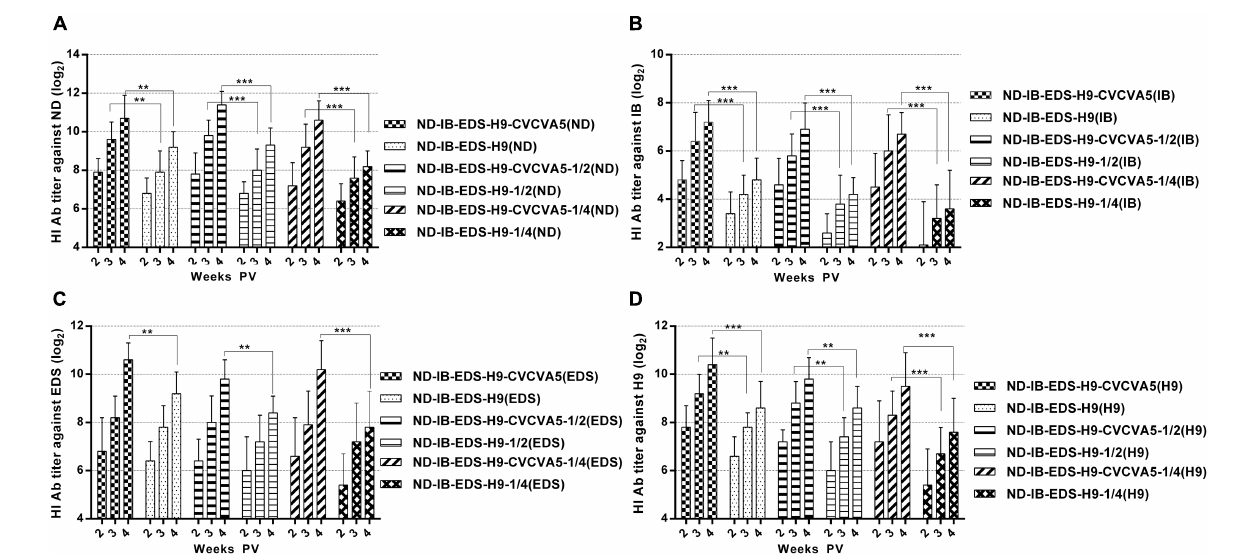
FIGURE 4 | Antibody titers elicited by the tetravalent vaccines. ND-IB-EDS-H9-CVCVA5, one dose of CVCVA5 adjuvanted ND-IB-EDS-H9 vaccine. ND-IB-EDS-H9, one dose of commercial ND-H9 vaccine without CVCVA5. ND-IB-EDS-H9-CVCVA5-1/2, half dose of CVCVA5 adjuvanted ND-IB-EDS-H9 vaccine. ND-IB-EDS-H9-1/4, antigen-sparing vaccine containing one quarter of antigen contents as those of the ND-IB-EDS-H9 standard commercial vaccine. ND-IB-EDS-H9-CVCVA5-1/4, adjuvanted antigen-sparing vaccine. The testing antigens were ND (A) , IB (B) , EDS (C) , H9 (D) , respectively. ∗∗ P < 0.01, ∗∗∗ P <